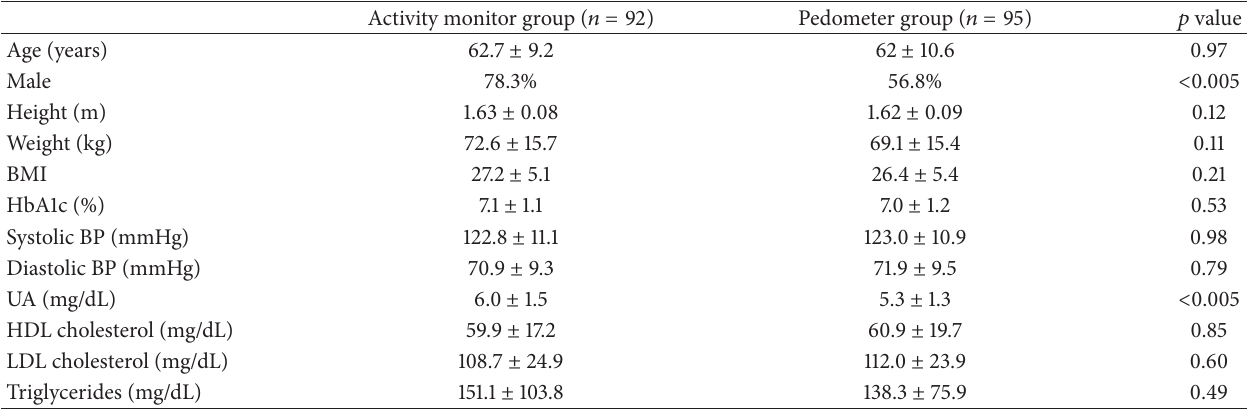
Figure 2: The explanatory pamphlet for exercise therapy. Examples of moderate-intensity exercises for the patients who participated in the study of both the activity monitor and the pedometer groups. The exercise goal of at least 20 minutes and 8,000 steps a day was based on the pamphlet. Table 1: Clinical characteristics of the activity monitor group and pedometer